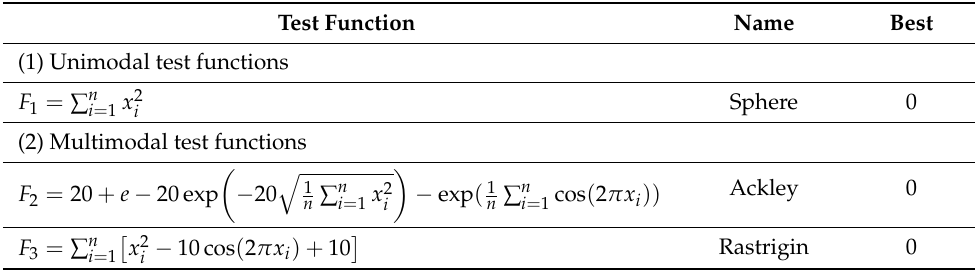
Table 3. Parameter of test